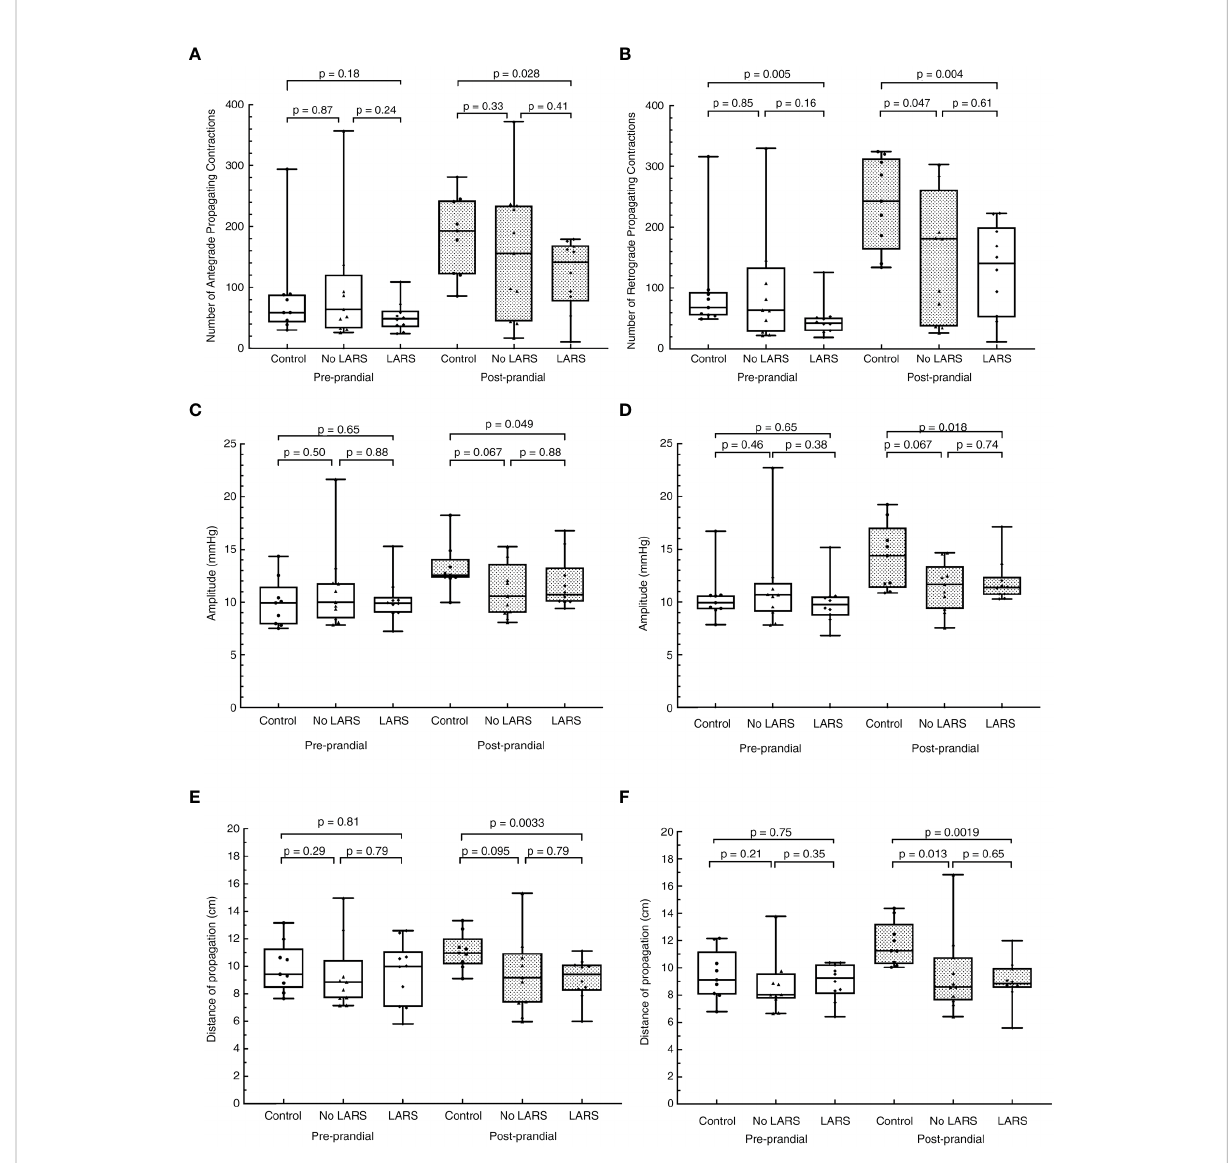
FIGURE 3 Adapted from Keane et al. with permission. Differences in the cyclic motor pattern in low anterior resection syndrome (LARS) compared to post- low anterior resection patients without LARS, and healthy controls. (A) number of antegrade contractions, (B) number of retrograde contractions, (C) amplitude of antegrade propagating contractions, (D) amplitude of retrograde propagating contractions, (E) distance of propagation of antegrade contractions, and (F) distance of propagation of retrograde propagating contractions. The resection group is made up of patients who scored ≤ 20 on the LARS